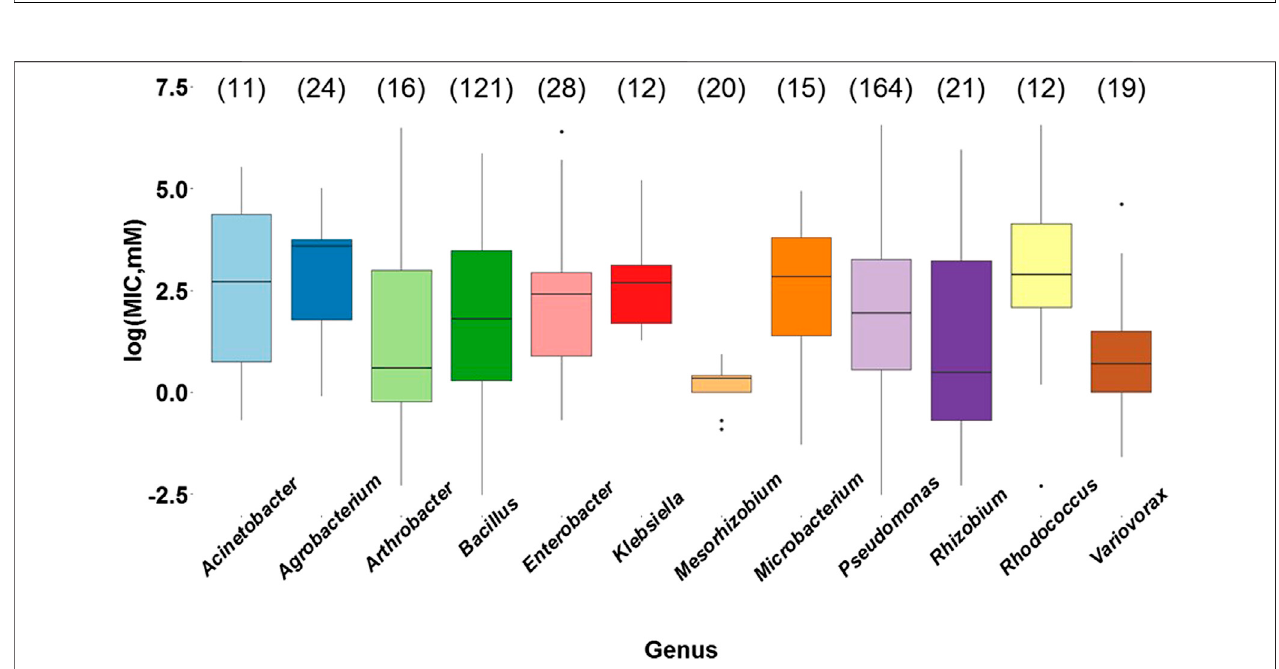
FIGURE 5 | Bacterial metal tolerance expressed as the logarithm of the Minimum Inhibitory Concentration (MIC) as a function of the most commonly reported bacterial genera ( Acinetobacter, Agrobacterium, Arthrobacter, Bacillus, Enterobacter, Klebsiella, Mesorhizobium, Microbacterium, Pseudomonas, Rhizobium, Rhodococcus, and Variovorax ),analyzedwithANOVAinRStudio3.5.1.Thedatapresentedcorrespondtoatotalof463MICvaluesobtainedfromtheselectedresearch articles. The number of reports for each genus is indicated in parentheses.